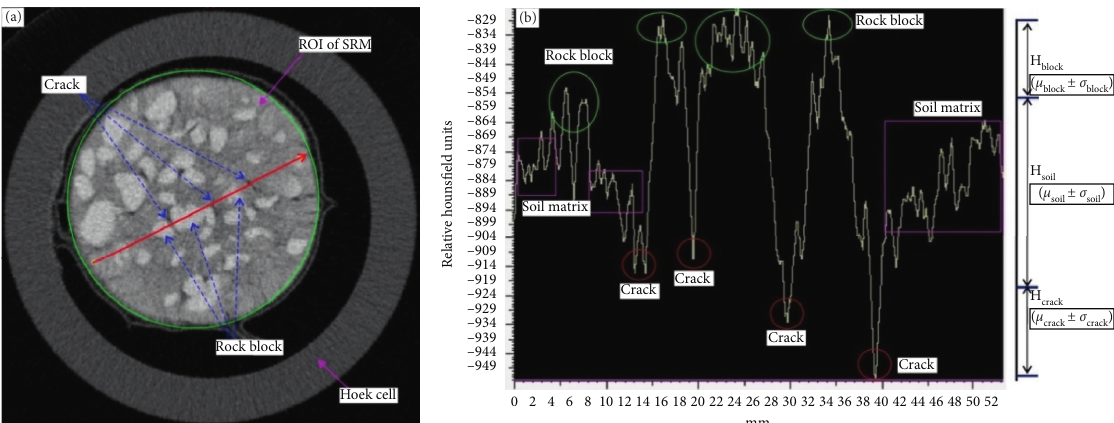
Figure 4: Illustration of the method to extract the cracks and rock blocks in CT image. (a) Cross-sectional slice (16-bit) and (b) gray level